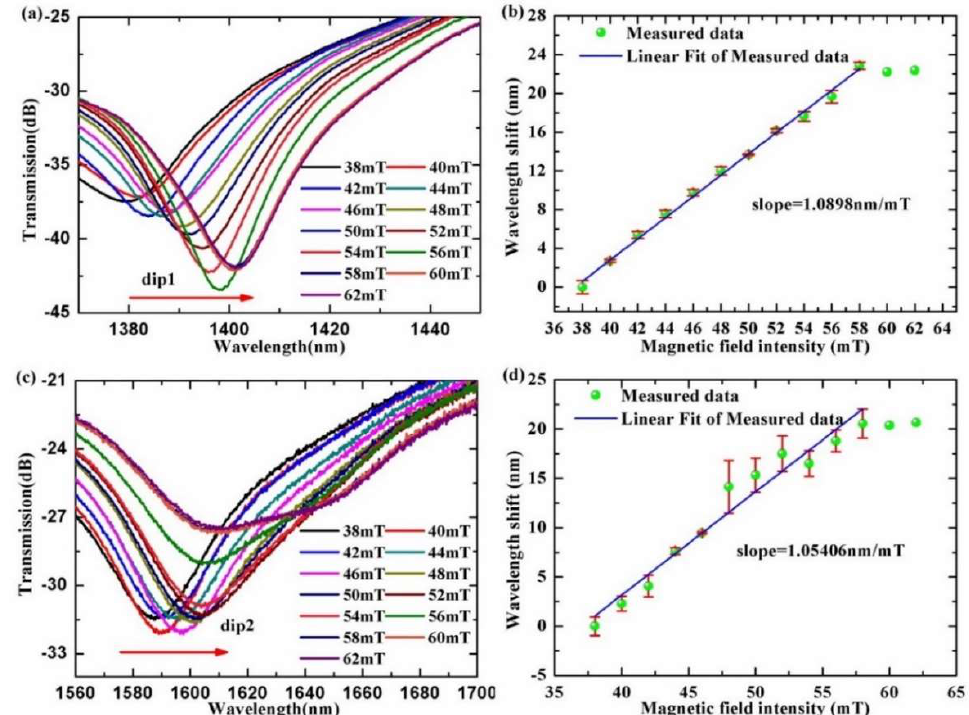
Figure 5. ( a , c ) Wavelength shifts of the dip1 and the dip2 of the interference spectra with the magnetic field intensity. ( b , d ) The wavelength shift trends of the dip1 and the dip2 of the interference spectra with magnetic field intensity.